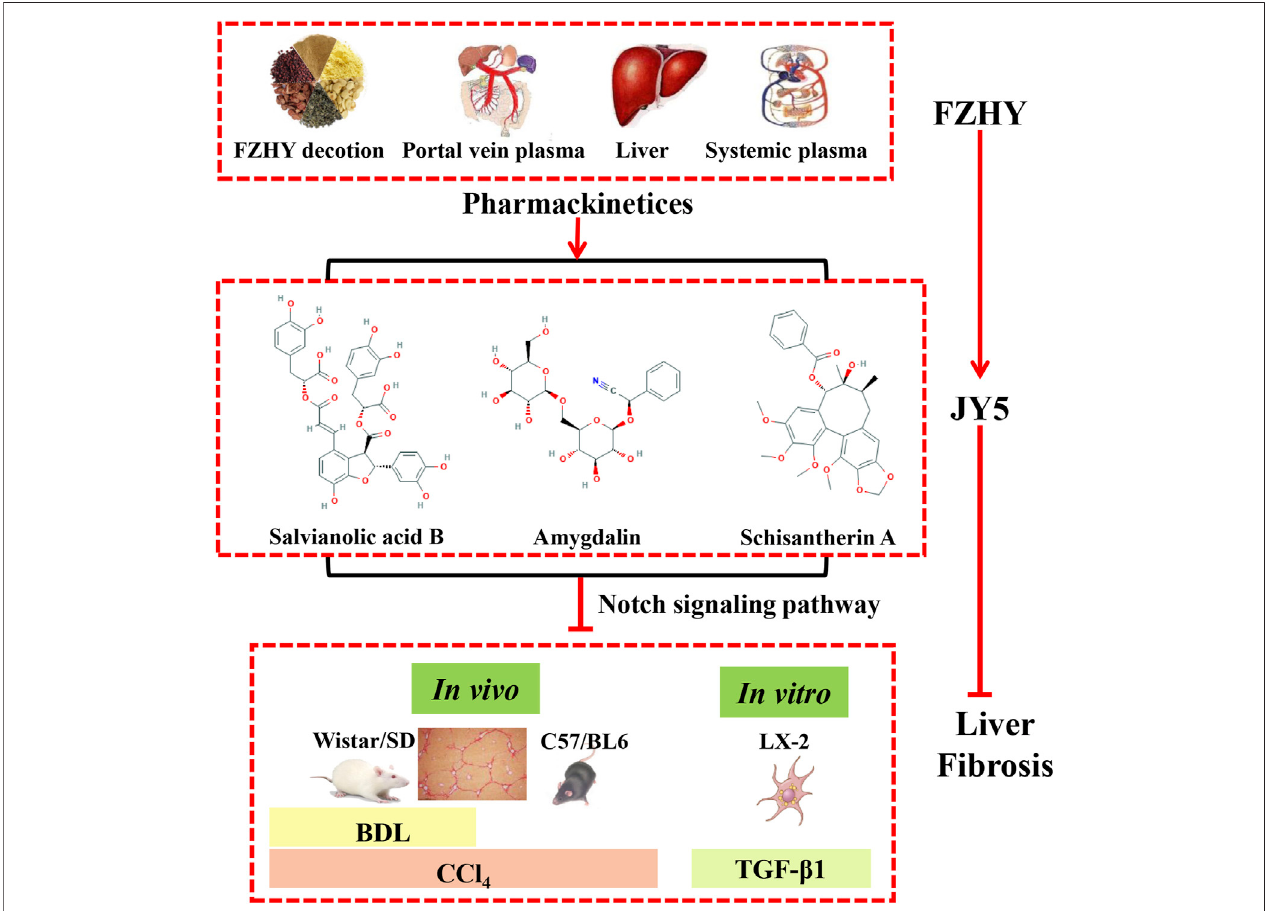
FIGURE 10 | A brief diagram of this study was shown. JY5 formula, which consists of the main active ingredients of FZHY, could exert anti-hepatic fi brotic effect through regulating Notch signaling pathway and inhibiting the activation of HSCs.